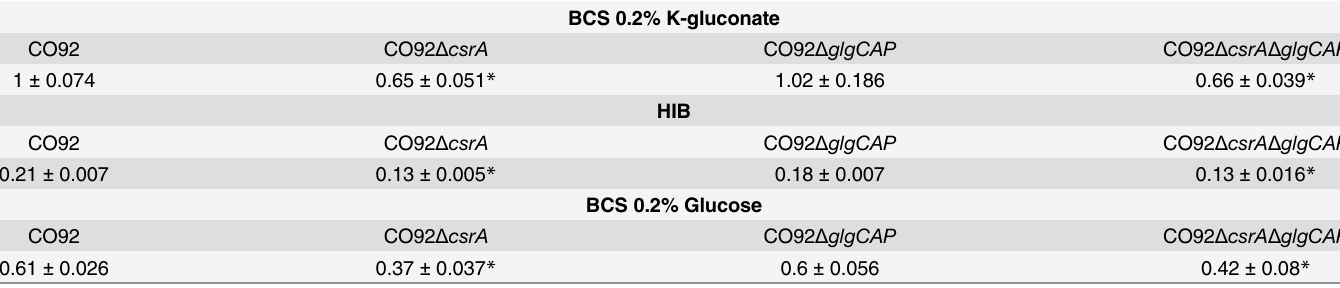
Table 2. Relative Crystal Violet Absorption of the CO92 Glycogen-deficient Mutants.